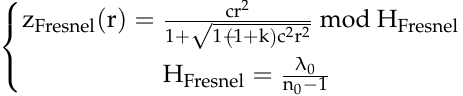
Figure 2. From a classical lens to a Fresnel lens and from a GRIN lens to a GRIN Fresnel lens. A GRIN lens works similarly to a conventional lens, and the radial index variation corresponds to the radial variation of the sag surface for a conventional lens. The surface sag (z Fresnel ) of a lens is defined by its curvature and its conicity. The surface sag of a Fresnel lens is described in Equation (3) [35], and it corresponds to the sag surface of a conventional lens that is divided into a series of rings.